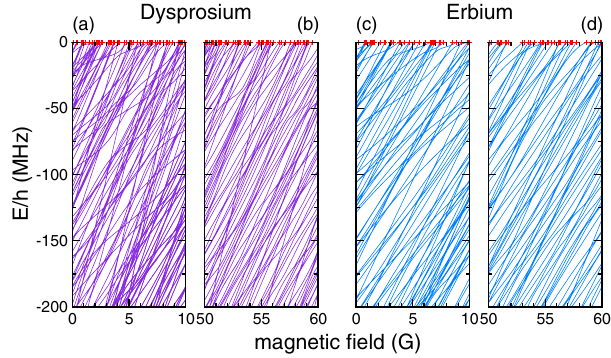
FIG. 5. Theoretical 164 Dy 2 [(a),(b)] and 168 Er 2 [(c),(d)] near- threshold bound states as a function of magnetic field. Calcu- lations have been performed with the full nominal anisotropy. Panels (a) and (c) show the near-threshold region between B ¼ 0 and 10 G, while panels (b) and (d) show the region between B ¼ 50 and 60 G. Red crosses indicate the location of Feshbach resonances.